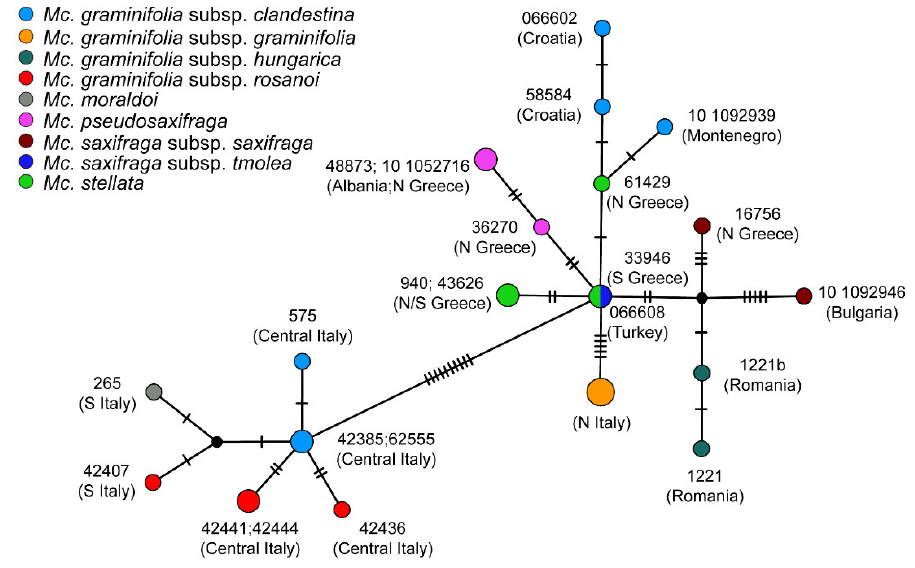
Figure 4. Chloroplast DNA TCS network. Dashes indicate the number of mutations separating haplotypes; the size of nodes is proportional to the number of identical haplotypes.